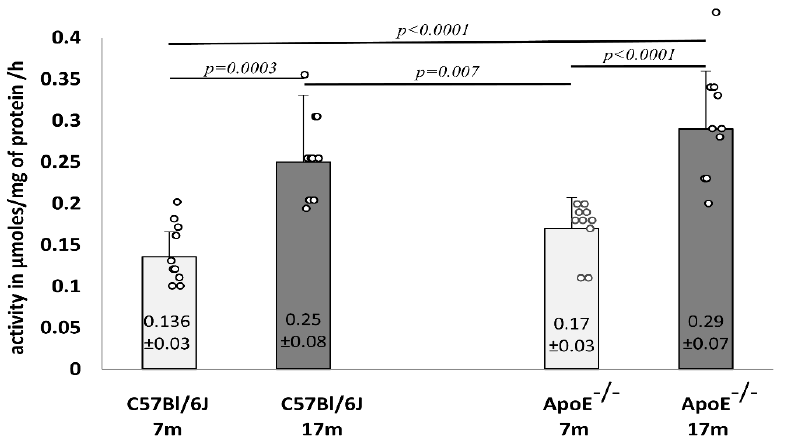
Figure 9. Senescence-related increase in the activity of β-galactosidase in the liver tissue of 7-month-old and 17-month-old C57Bl/6J and ApoE −/− mice. Data were analyzed by a two-way ANOVA test (exact F values for genotype and age are 3.26 and 34.27, respectively) followed by a Dunn–Sidak’s multiple comparison post-hoc test. Shown are the means ± standard deviations. The significance of differences between compared groups are marked with obtained p -values ( p ) for each significant comparison, the different genotype groups were not littermates; row data are depicted by circles; m-months.